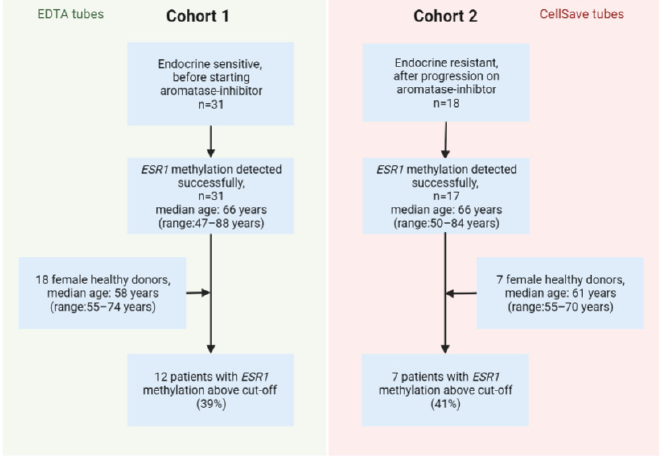
Figure 2. Flow chart of patient samples and healthy donor samples that were included in this study.